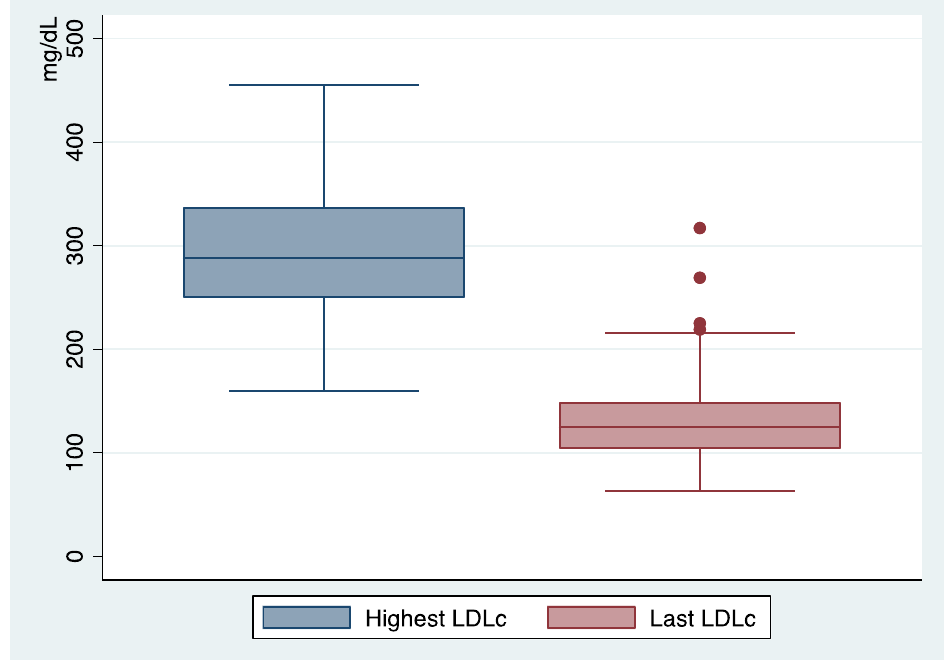
Figure 2. Highest LDLc and most recent LDLc recorded levels (md/dL).